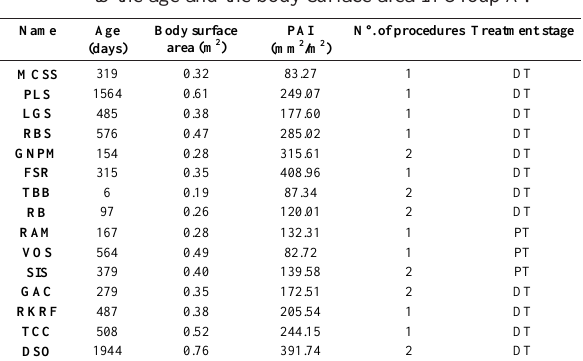
Table 1. Morphometric characteristics of the pulmonary arteries, surgical procedures and stages of treatment in relation to the age and the body surface area in Group A.